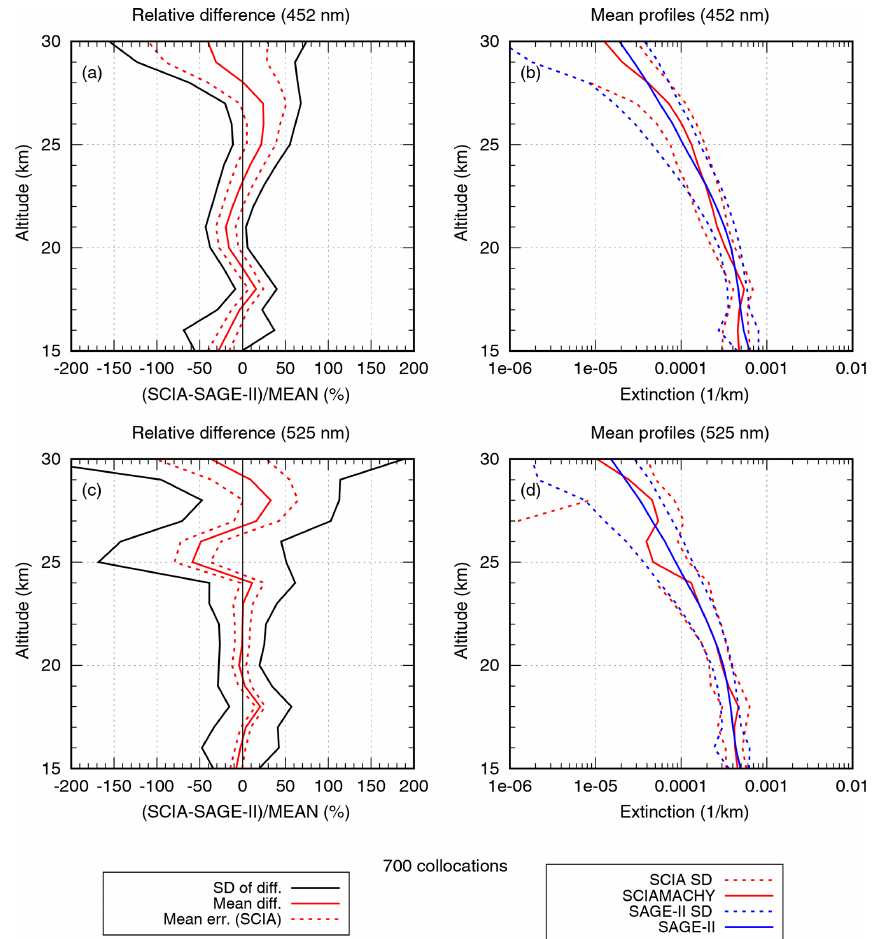
Figure 9. Comparison between aerosol extinction profiles from SCIAMACHY solar occultation and collocated SAGE-II data. (a) Relative differences at 452nm (solid red), mean SCIAMACHY error (dashed red) and standard deviation of differences (black). (b) Mean aerosol extinction profiles at 452nm (solid) and corresponding standard deviations (dashed) for SCIAMACHY (red) and SAGE-II (blue). (c) Same as panel (a) but for 525nm. (d) Same as panel (b) but for